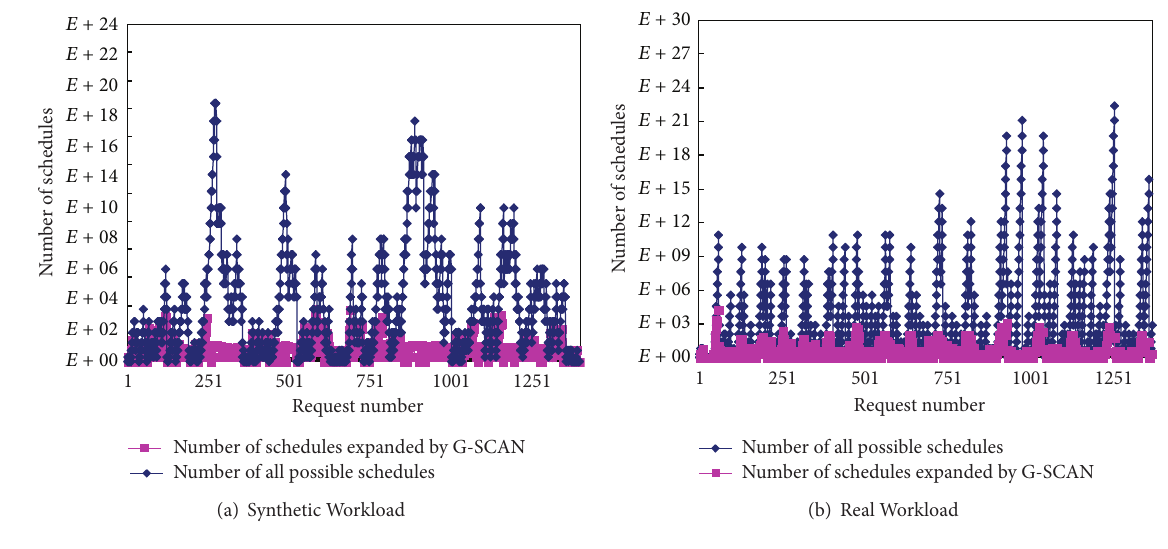
Figure 11: The overhead of G-SCAN as time